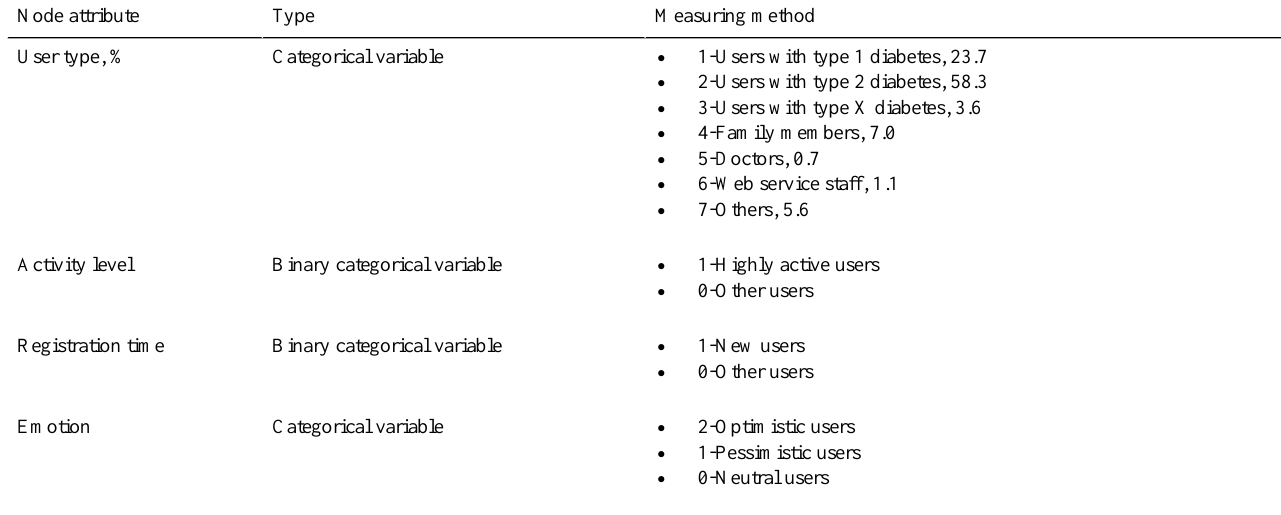
Table 1. Operationalization of nodal